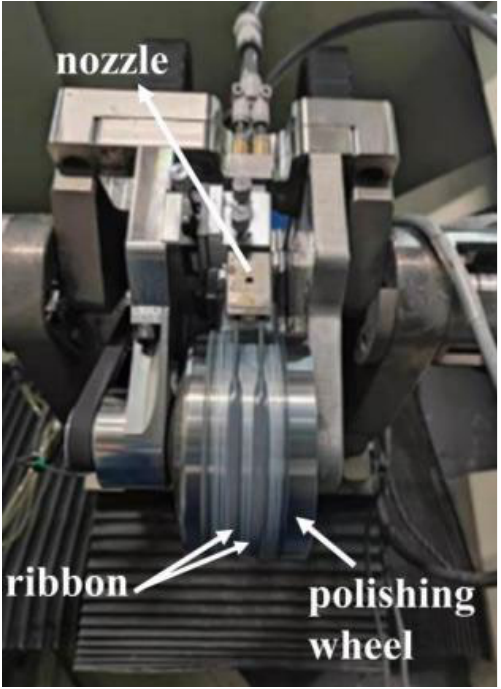
Figure 2. Ultra-smooth surface laser scattering quality detection device.